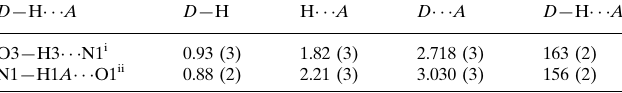
Hydrogen-bond geometry (A˚ , (cid:4)